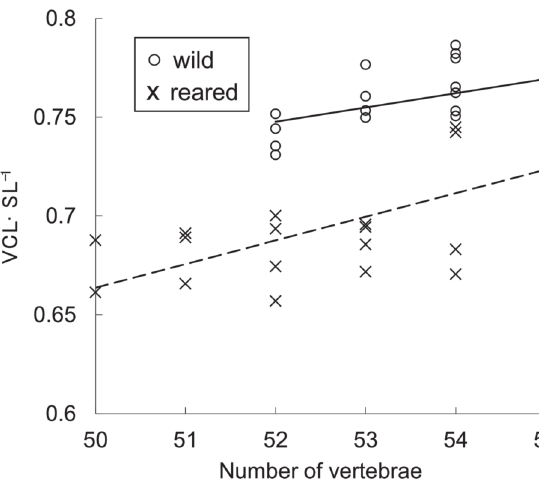
Fig. 2. Correlation between number of vertebrae and ver- tebral column length (VCL) per body length (SL) of hatchery-reared- (reared) ( n = 19) and wild ( n = 20) Pacific herring, Clupea